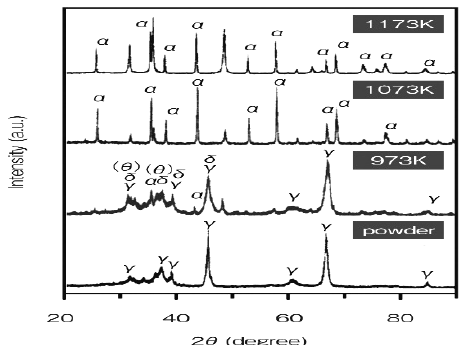
Figure 27. XRD patterns of γ-Al 2 O 3 prepared at 973–1173 K, under 690 MPa.